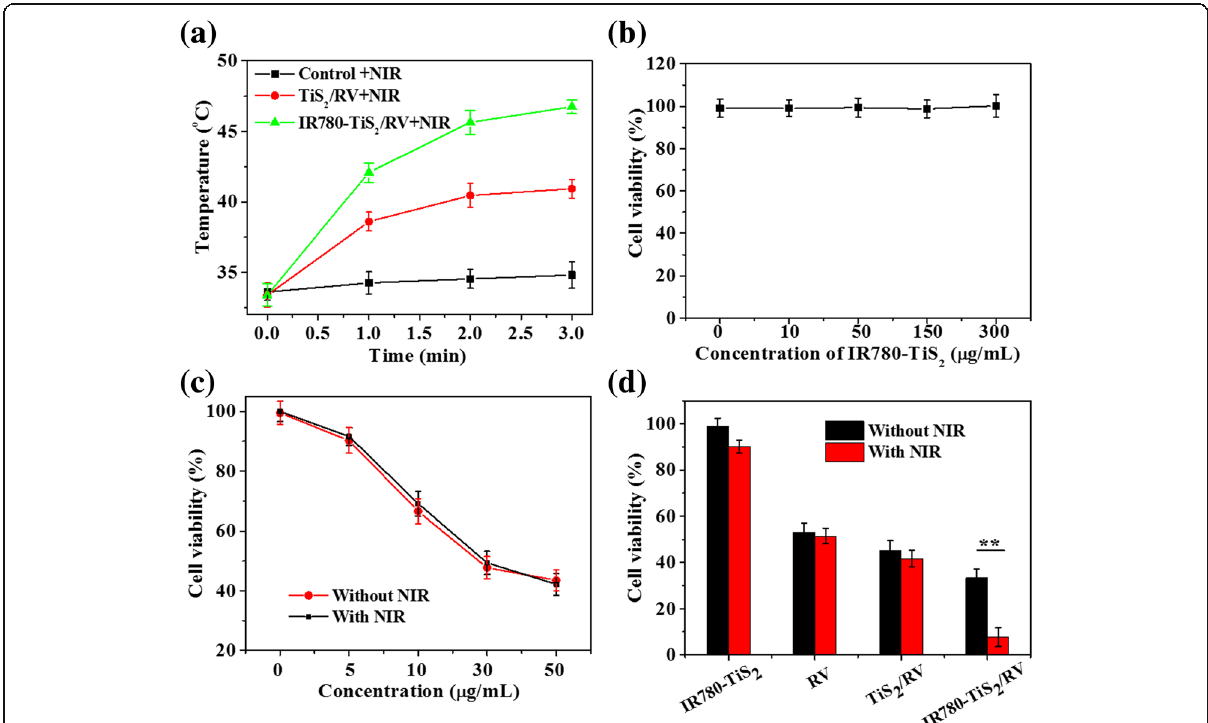
Fig. 4 a The temperature change curves of PBS (control), TiS 2 /RV, or IR780-TiS 2 /RV-treated cells under a 3-min NIR irradiation (808 nm, 0.3 W/cm 2 ). b In vitro cytotoxicity against CT26 cells treated with different concentrations of IR780-TiS 2 . c Cell viability of cells treated with RV with or without NIR irradiation (808 nm, 0.3 W/cm 2 ) for 3 min. d Cell viability of cells treated with IR780-TiS 2 , RV, TiS 2 /RV, or IR780-TiS 2 /RV with or without NIR irradiation (808 nm, 0.3 W/cm 2 ) for 3 min. **P < 0.01, compared with IR780-TiS 2 /RV without NIR group